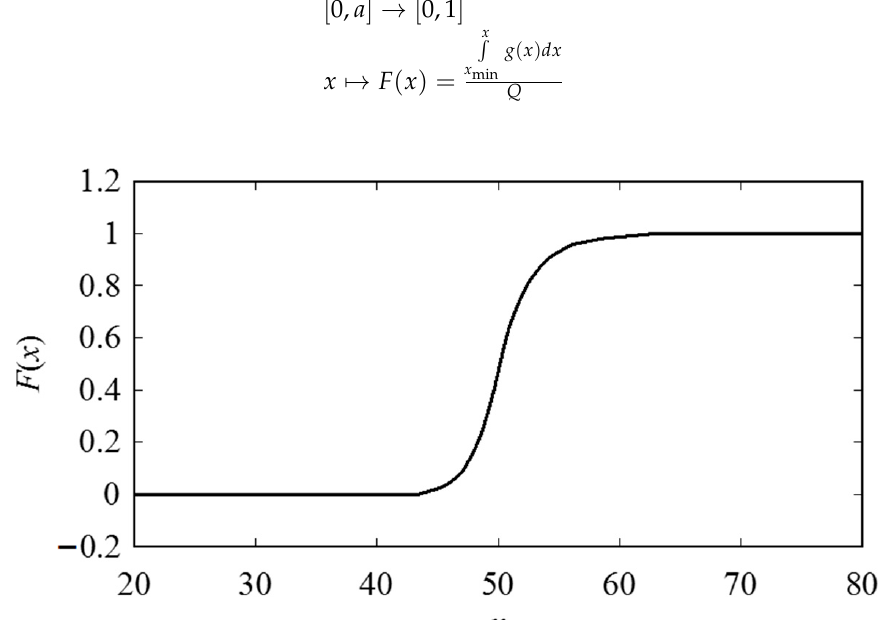
Figure A5. Nature of cumulative probability distribution of a point-cloud.